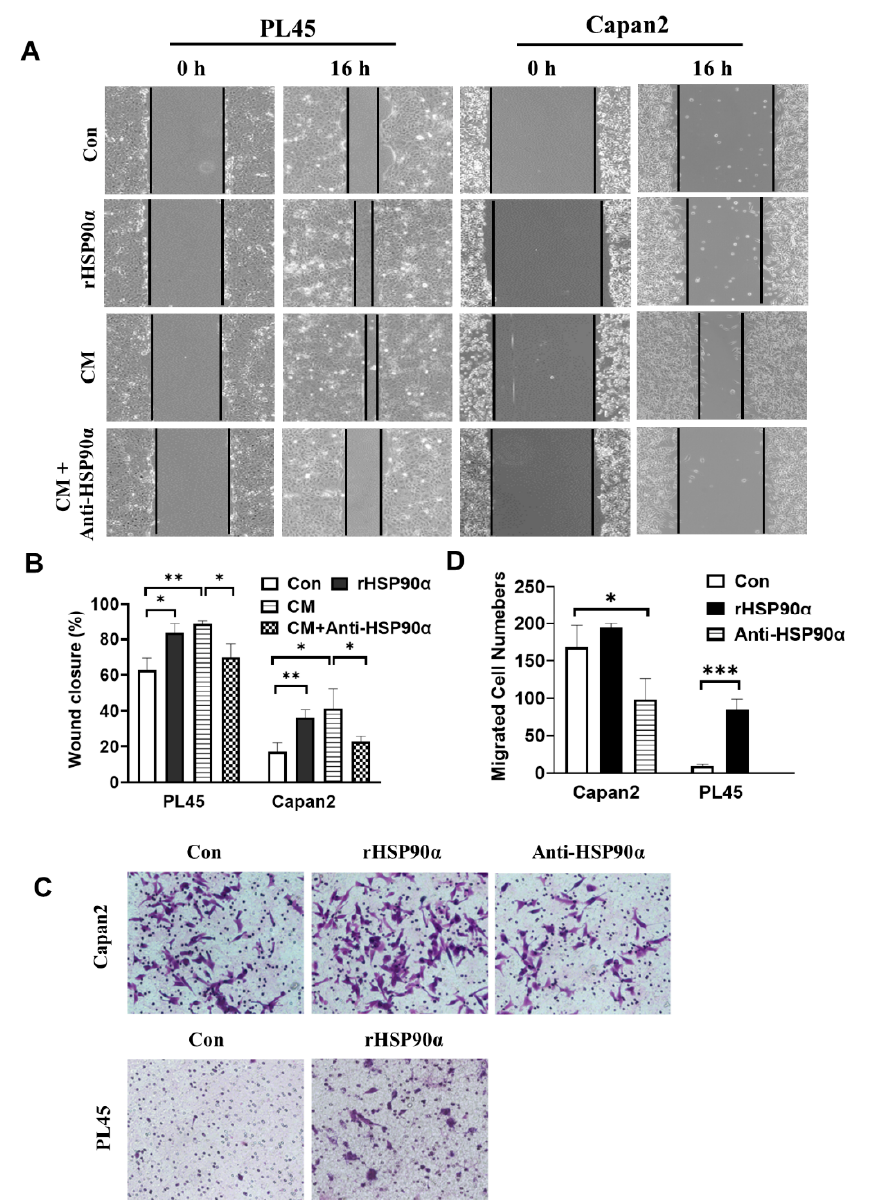
Figure 2. Secreted HSP90 α induces the migration and invasion of PC cells. ( A ) Exogenous HSP90 α increases the migration activities of PC cells. PL45 and Capan-2 cells were treated with 10 µ g/mL of rHSP90 α and CM with or without the anti-HSP90 α antibody (5 µ g/mL) for 16 h, and the migratory ability of cells was detected by wound-healing assays. ( B ) The wound closure rates at the indicated time points were shown as mean ± SD of three independent measurements. * p ≤ 0.05 and ** p ≤ 0.01. ( C ) rHSP90 α increases cell invasiveness in PC cells. PL45 and Capan ‐ 2 cells were treated with PBS, rHSP90 α (10 μ g/mL) or the anti ‐ HSP90 α antibody (5 μ g/mL) for 24 h and allowed to invade through Matrigel for 16 h. Invasive cells on the filters of the Transwell inserts were measured under a microscope. ( D ) The graphs show the quantitative evaluation of the migrated cell counts. Data are represented as the mean ± SD of three independent measurements. ** p ≤ 0.01 and *** p ≤ 0.001.